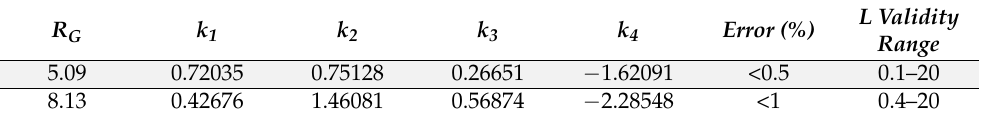
Table 3. Pure positive and negative feedback at platinum and PTFE surfaces [19,20].